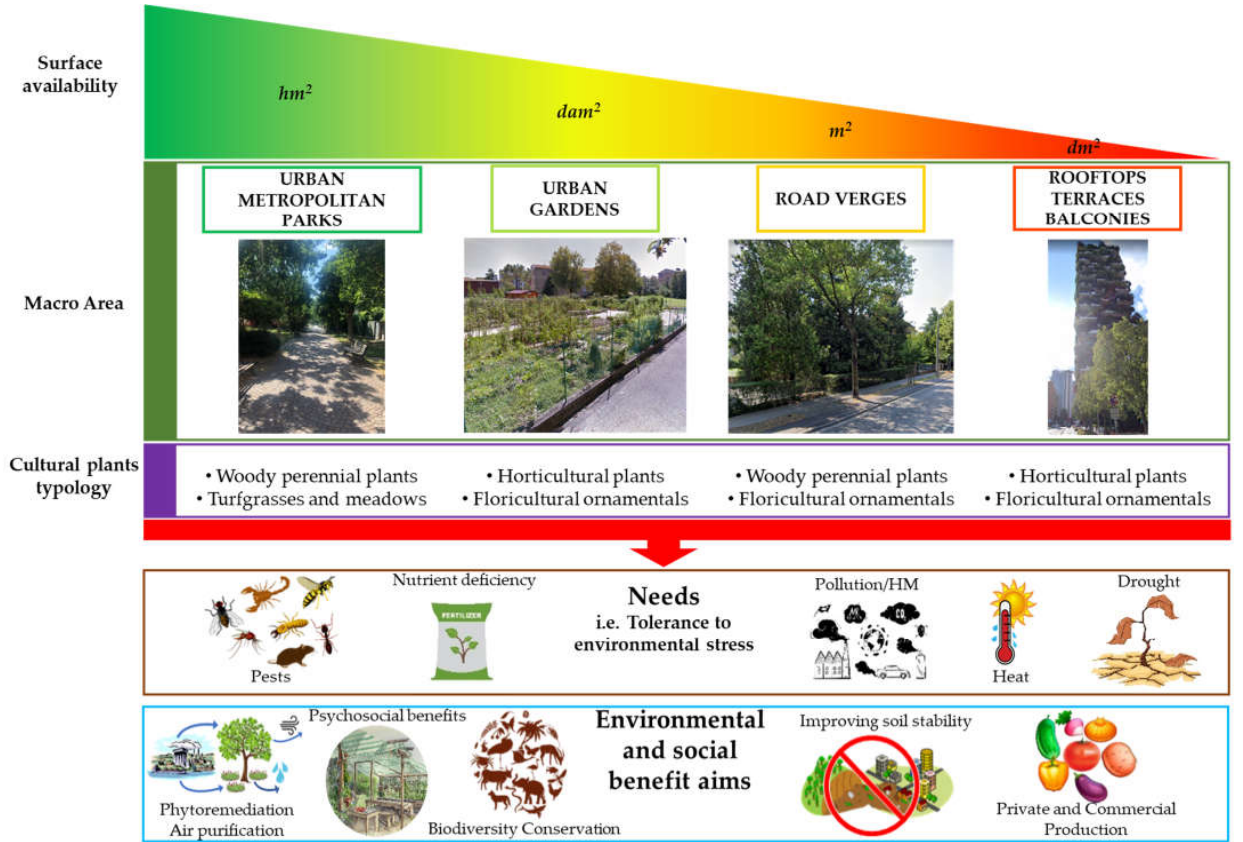
Figure 1. Schematic representation of the multilayered framework of the most common contexts, here defined as Macro Areas, found in an urban environment. In each macro area, the goals to achieve are multiple and specific, depending on the characteristics and needs of every specific zone, and specific vegetation type that is desired to use. However, under all conditions, the need to use specific cultural plant typology able to cope and tolerate environmental stresses is a fundamental requirement. In addition, the potential environmental and social benefits deriving from them are indicated. Details are described in the text.